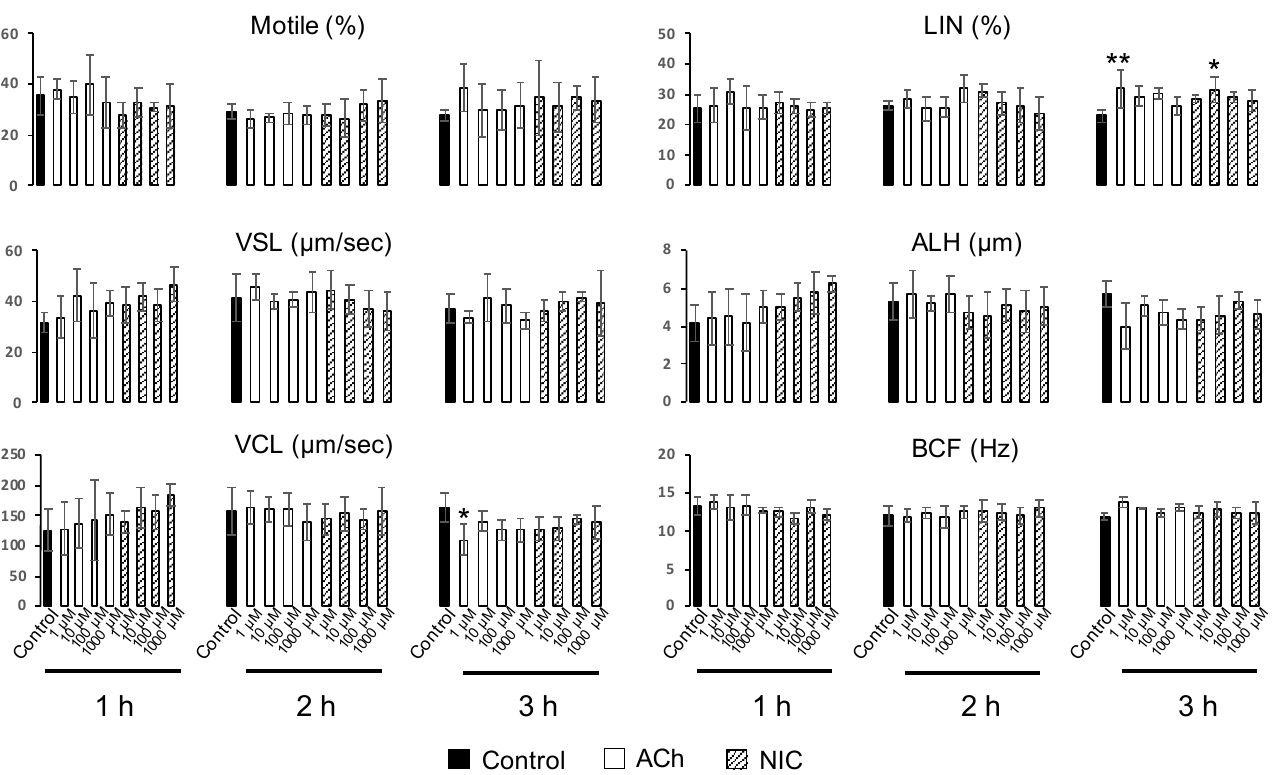
Figure 5. Computer-assisted sperm analysis (CASA) measurements of the effects of ACh and NIC on mouse sperm motility. Data shown as mean ± SD ( n = 4; * p < 0.05; ** p < 0.01). VSL, straight-line velocity; VCL, curvilinear velocity; LIN, linearity; ALH, amplitude of lateral head displacement; BCF, beat cross frequency.